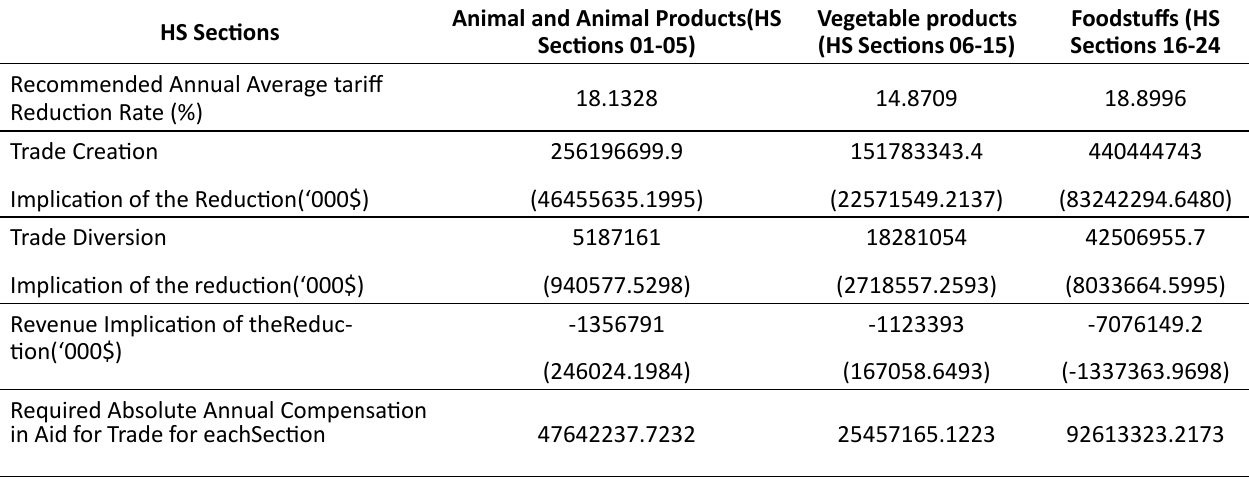
Table 4: Recommended Annual Aid for Trade Schedule Provisions across Product